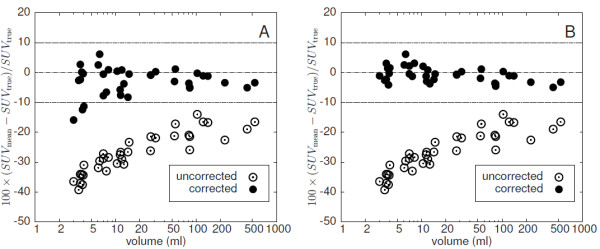
Deviation of GBPVC-corrected (A) and LBPVC-corrected (B) SUVmeanfrom the true SUVmeanusing automatic ROI delineation (at a noise level of FWHM = 5%). The uncorrected SUVmean is shown for comparison. Note the logarithmic scale of the abscissa.